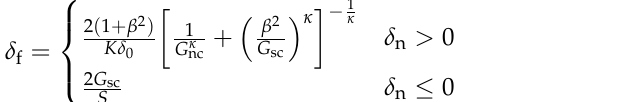
(cid:113) (cid:104) δ (cid:105) 2 + δ 2 exceeds δ 0 , it indicates the n t